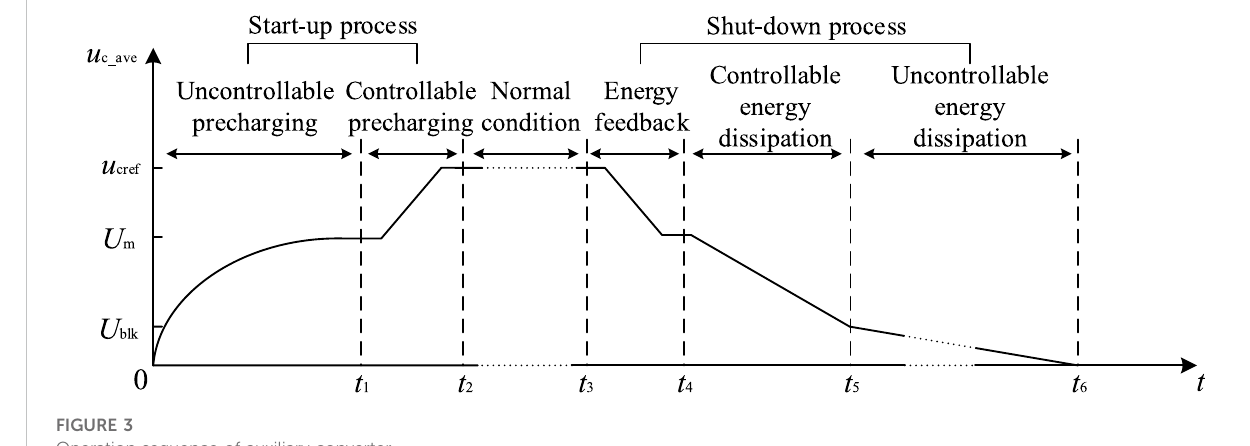
FIGURE 3 Operation sequence of auxiliary converter.